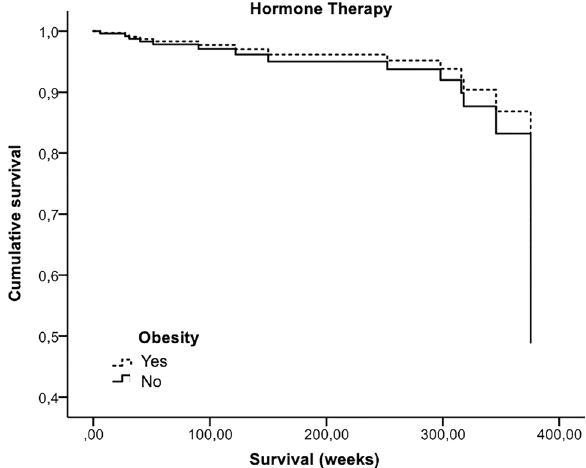
Image 5. Survival curve, in the Kaplan-Meier assessment, relating obesity, according to patient age groups, among patients undergoing